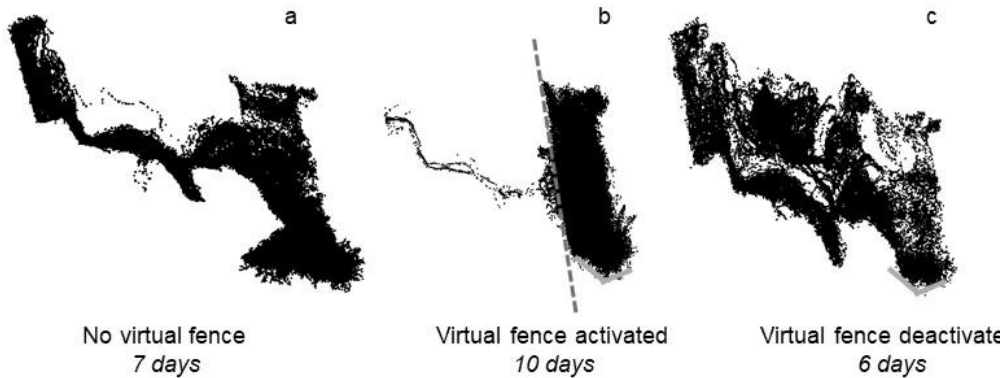
Figure 2. The GPS locations of all animals in the virtual fencing trial on a commercial riparian zone property. Images display cattle movement: ( a ) when no virtual fence was present; ( b ) when a virtual fence was activated (dashed line); and ( c ) when that virtual fence was subsequently deactivated with days of each period length indicated. Solid grey lines indicate a physical electric fence that was placed to remove a corner zone of the paddock that would have been logistically difficult for the cattle once the virtual fence was activated.